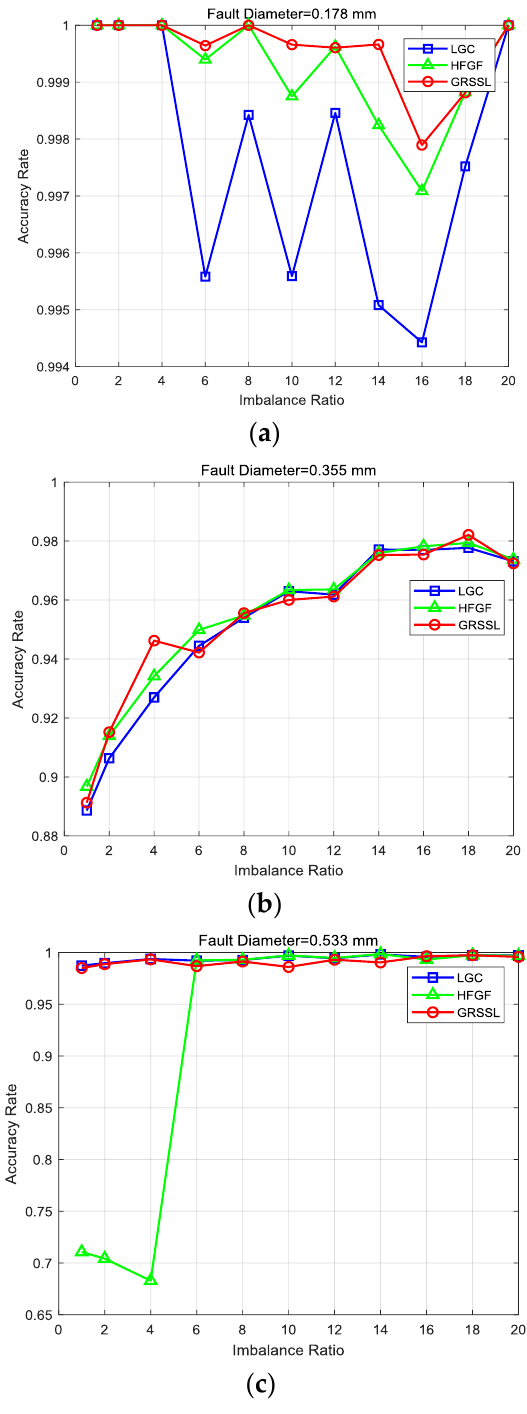
Figure 8. Performance of Local and Global Consistency (LGC), Gaussian Fields and Harmonic Functions (GFHF), and graph-based rebalance semi-supervised learning (GRSSL) algorithms using the bearing data with a fault diameter of ( a ) 0.178 mm, ( b ) 0.355 mm and ( c ) 0.533 mm.